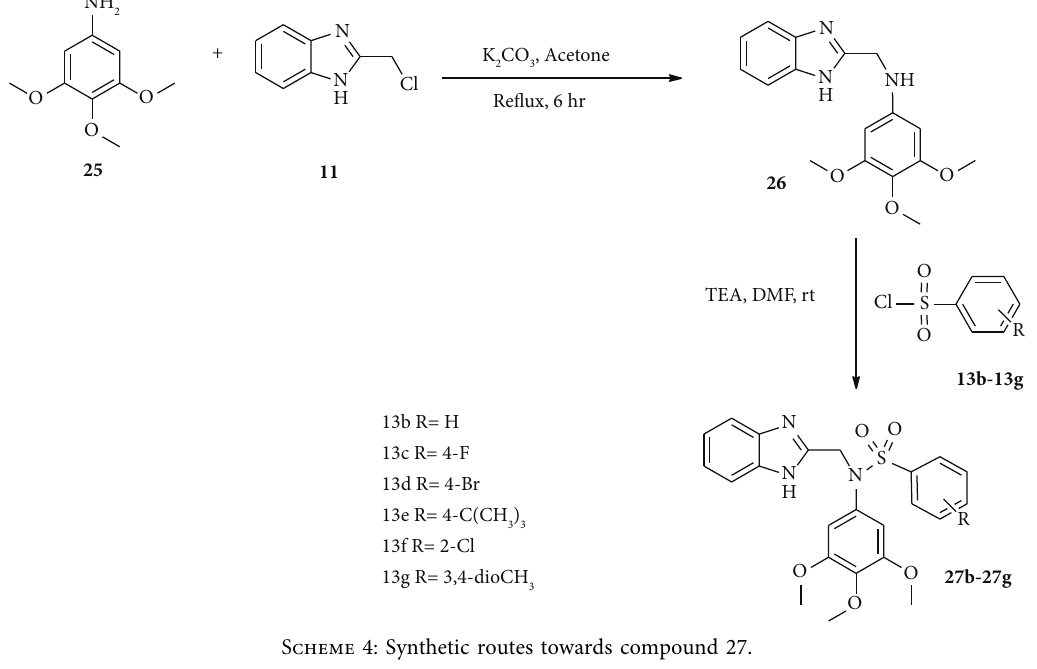
Scheme 4: Synthetic routes towards compound 27.